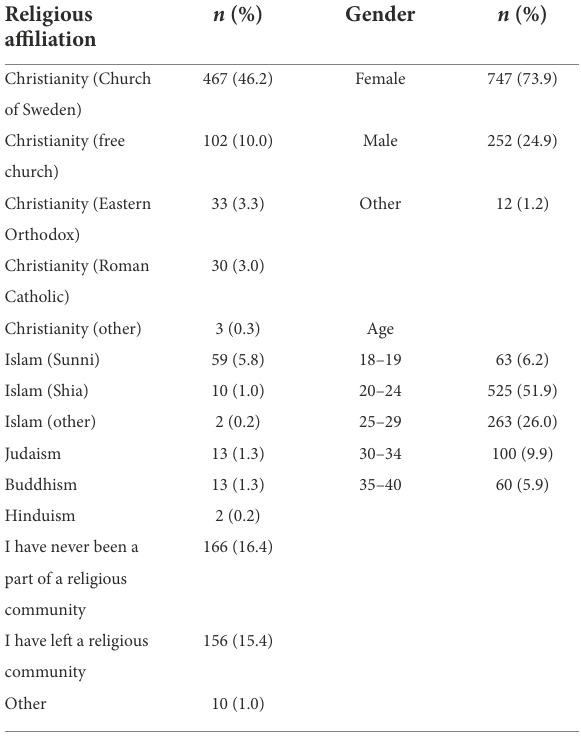
TABLE 1 Selected sociodemographic